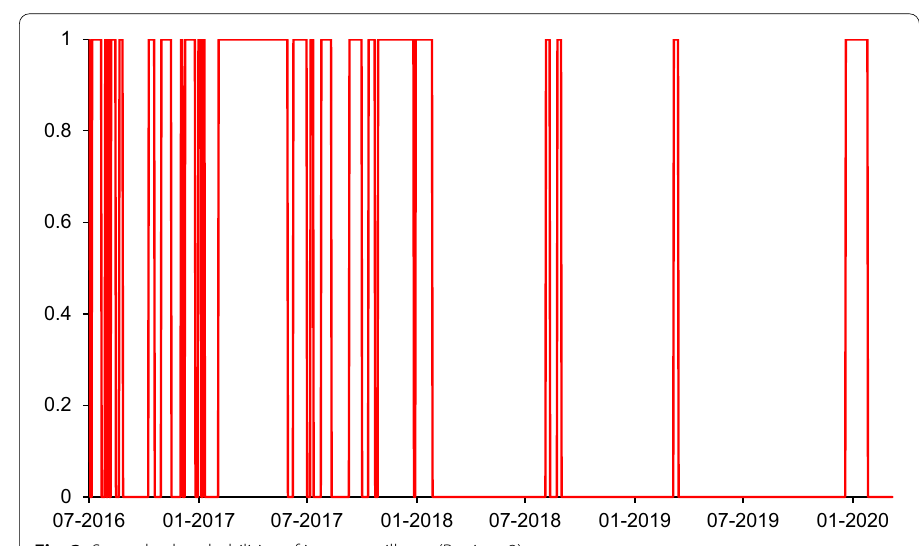
Fig. 3 Smoothed probabilities of intense spillover (Regime